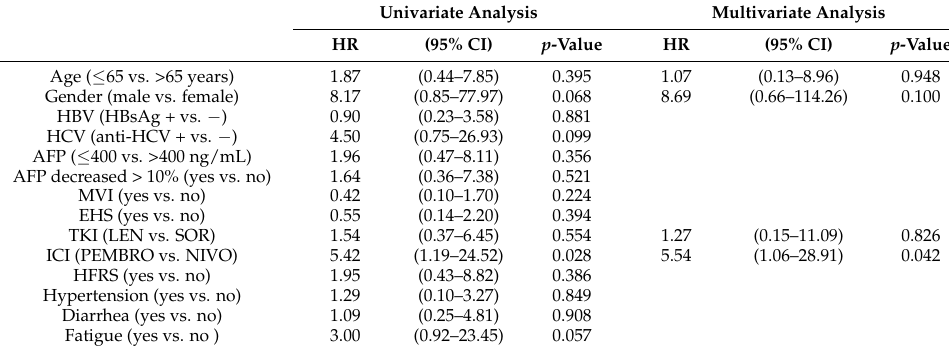
Table 3. Logistic analysis of each item to achieve objective response.